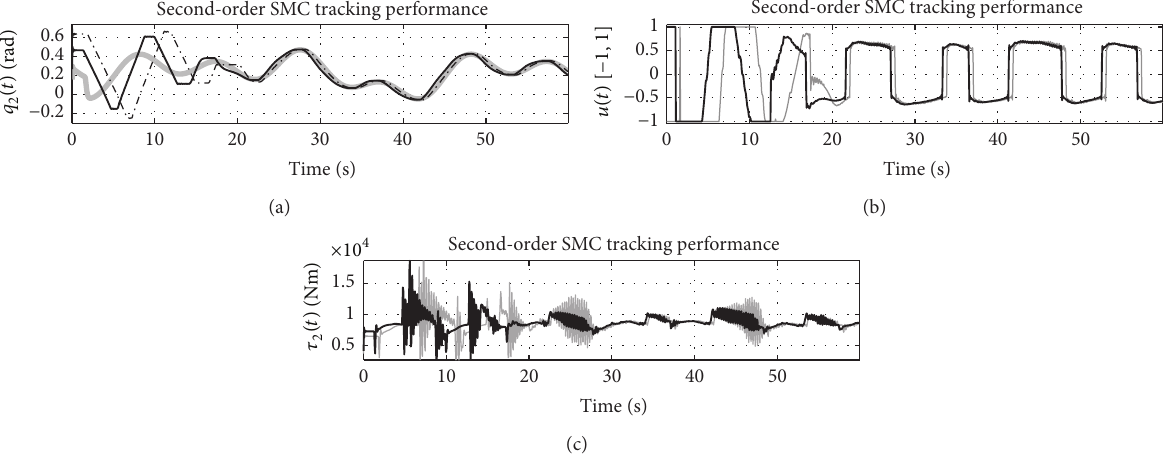
Figure 14: Experimental results of disturbance rejection with a second-order SMC. (a) Angular link displacement in radians . The bold signal shows the results applying the state-dependent method (48), thestriped signal shows resultswith the original formula (40), and the gray signal is the reference trajectory. (b) Control input . The bold signal shows the results applying the state-dependent method (48) and the gray signal shows results with the original formula (40). (c) Computed torque from pressure measurements . The bold signal shows the results applying the state-dependent method (48) and the gray signal shows results with the original formula